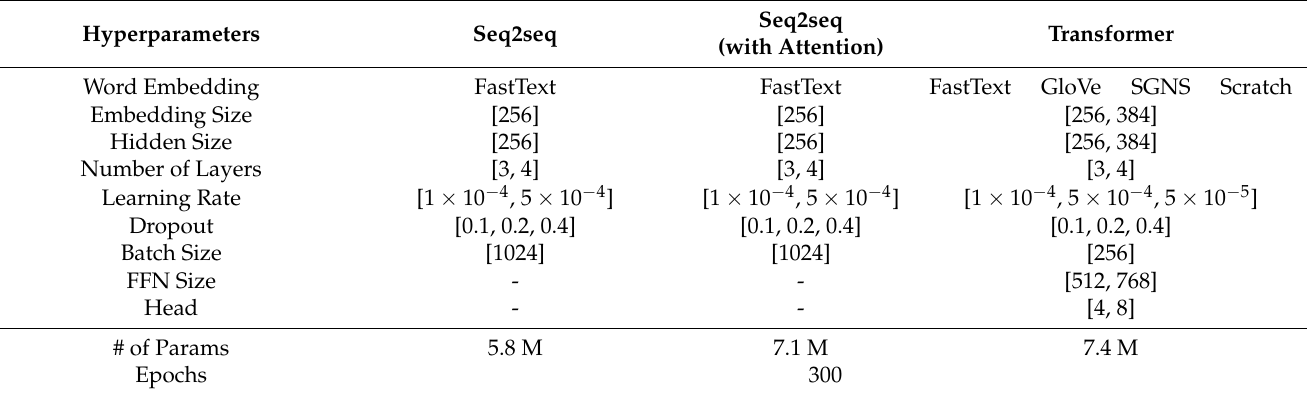
Table 6. Hyperparameters and values to consider for each model. Scratch indicates that the model is trained from scratch without an embedding